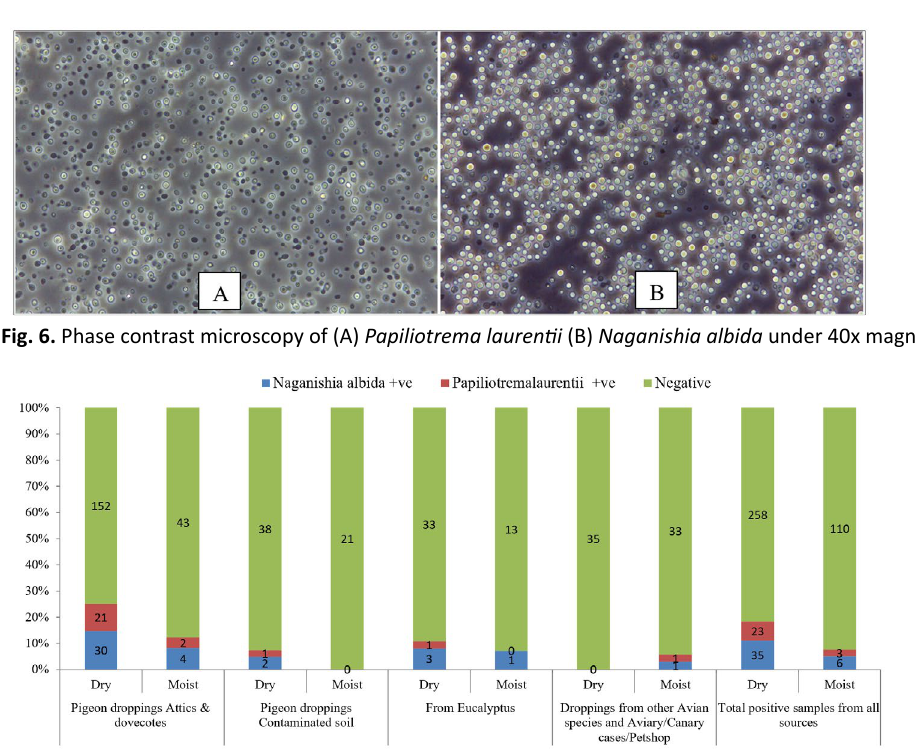
Fig. 7. Distribution of positive samples of Cryptococcus species isolated from samples and specimens